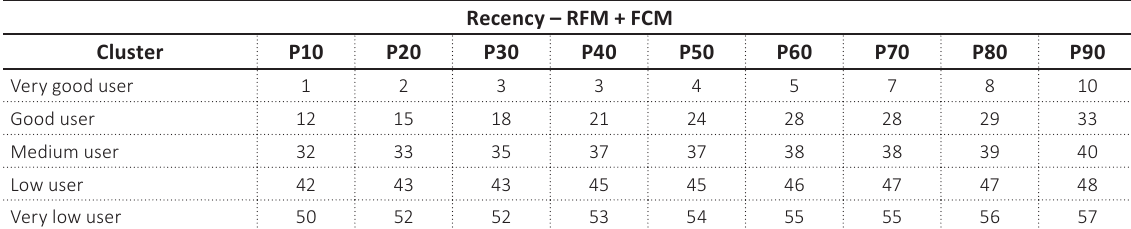
Table 4. Recency distribution